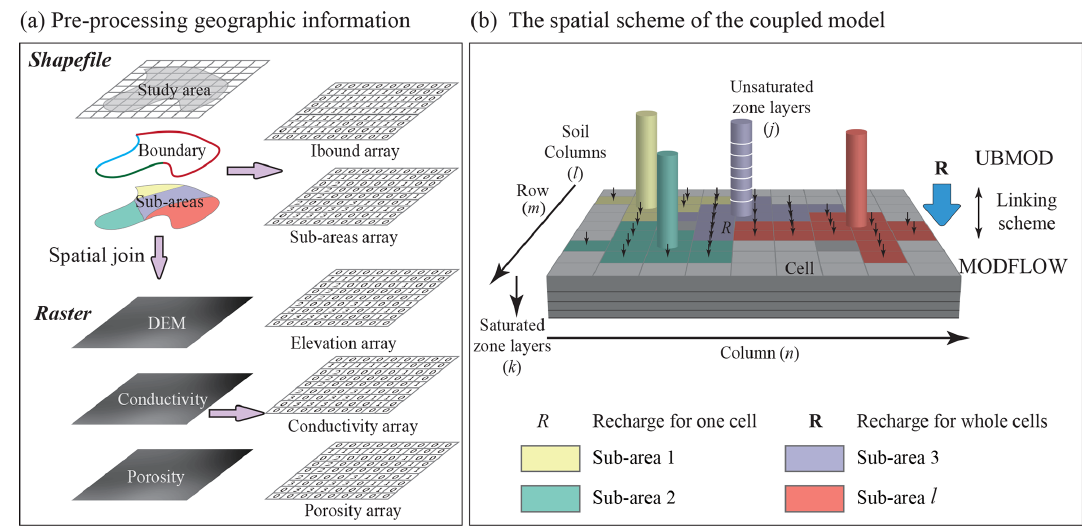
Figure 1. (a) The procedures of geographic input information preparation. (b) The spatial scheme of the coupled